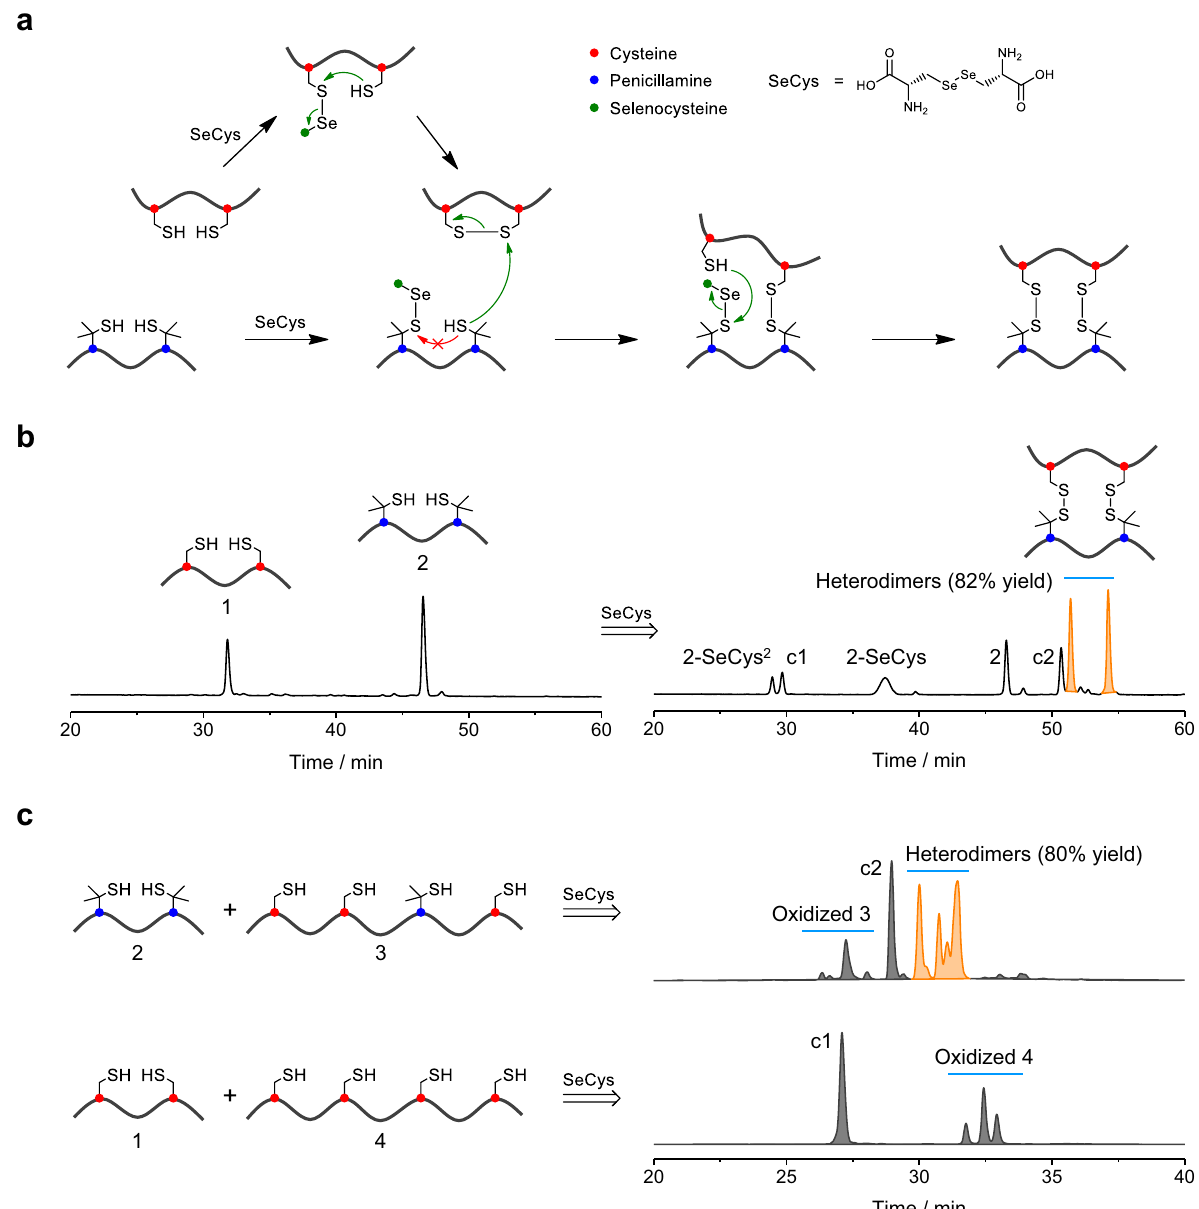
Fig. 1 Interchain disul fi de pairing chemistry for peptide heterodimerizations. a SeCys-mediated thiol-disul fi de exchanges between Cys and Pen residues to direct the heterodimerization of peptides with multiple disul fi de bonds. b HPLC chromatograms showing the oxidation of 1 (0.1mM; sequence: WGCGKG 3 CG) and 2 (0.2mM; sequence: WGPenGKG 3 PenG) in the presence of SeCys (0.05mM) in a phosphate buffer (100mM, pH 7.4); left: before oxidation, right: after 24h oxidation. Other peaks in HPLC: 2-SeCys, peptide 2 linked with one SeCys; 2-SeCys 2 , peptide 2 linked with two SeCys; c1: disul fi de-cyclic 1; c2, disul fi de- cyclic 2. c HPLC chromatograms showing the oxidation of 2 (0.2mM) and 3 (0.1mM; sequence: WGCG 2 KG 2 CGKG 3 PenGKG 3 CGW) in a phosphate buffer (100mM, pH 7.4) containing 0.05mM SeCys and the oxidation of 4 (0.1mM; sequence: WGCG 2 KG 2 CGKG 3 CGKG 3 CGW) and 1 (0.2mM) under the same condition. Source data are provided as a Source Data fi